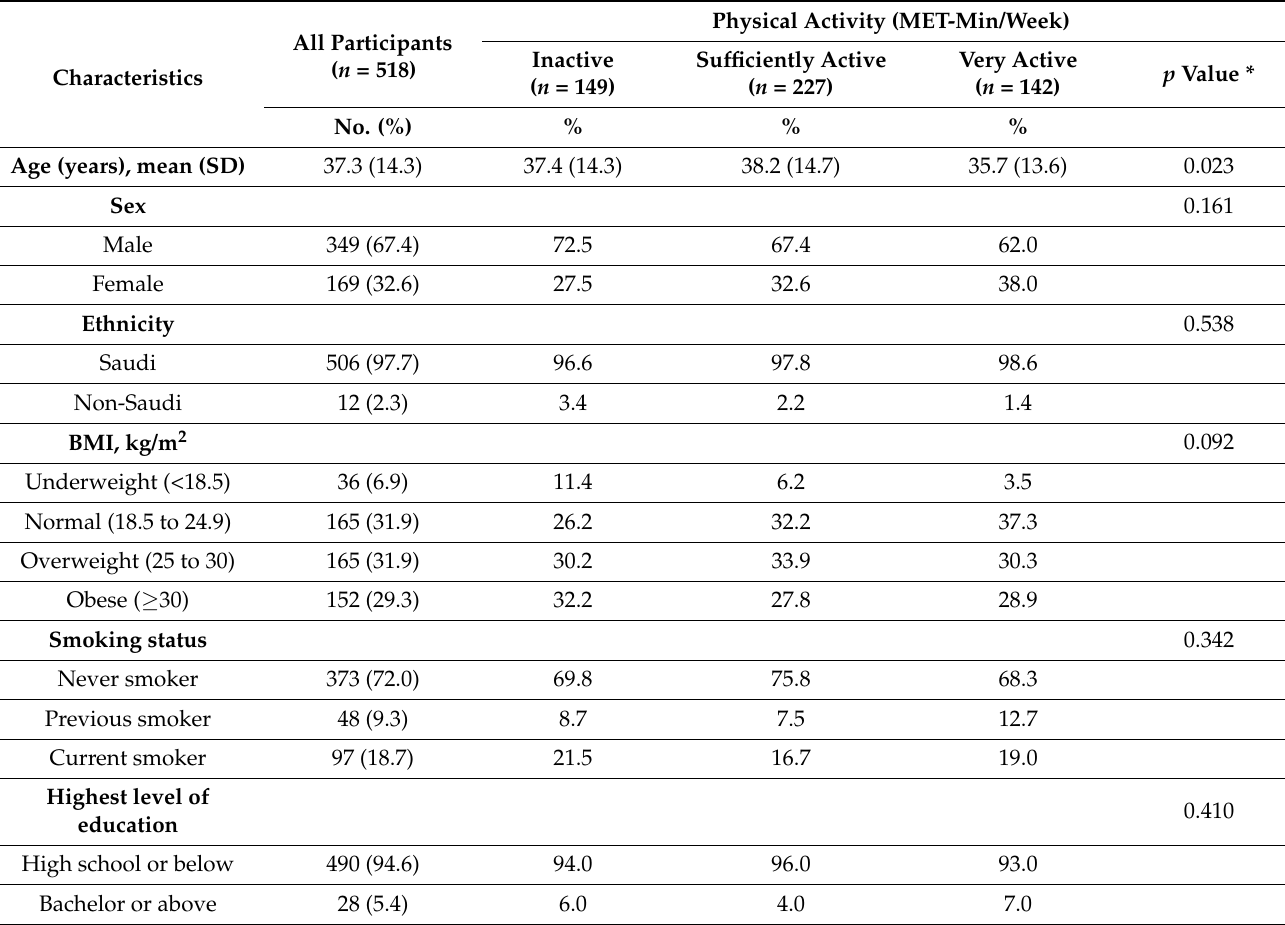
Table 1. Demographics and health-related characteristics of